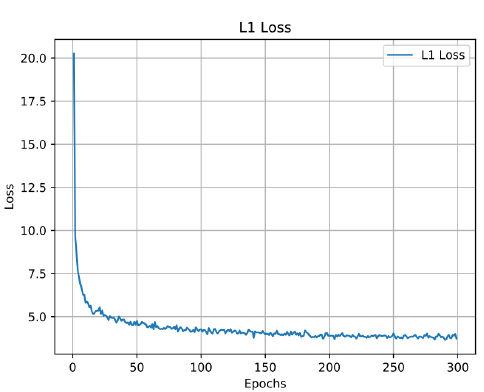
Figure 6. Relation between epochs and loss value of optimal PEMSR model. Table 9. Test results of the optimal PEMSR model. This model is trained after data augmentation by a factor of 8 and data balancing.